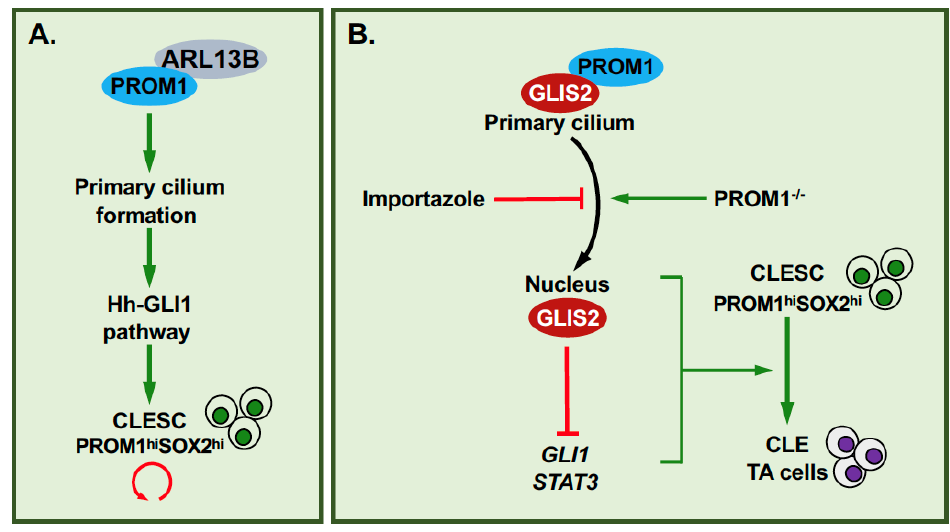
Figure 3. Link between PROM1, GLIS2, and stem cell renewal. ( A ) The interaction of PROM1 with the ciliary protein ARL13B promotes primary cilium formation and elongation leading to increased activation of the hedgehog (Hh)-GLI signaling pathway and stem cell renewal [84] . ( B ) GLIS2 interacts with PROM1 and localizes to the primary cilium. Loss of PROM1 promotes nuclear localization of GLIS2 where it represses the transcription of target genes, including GLI1 and STAT3, thereby inhibiting CLESC renewal and promoting their differentiation into CLE transient amplifying cells (TA) [44] .